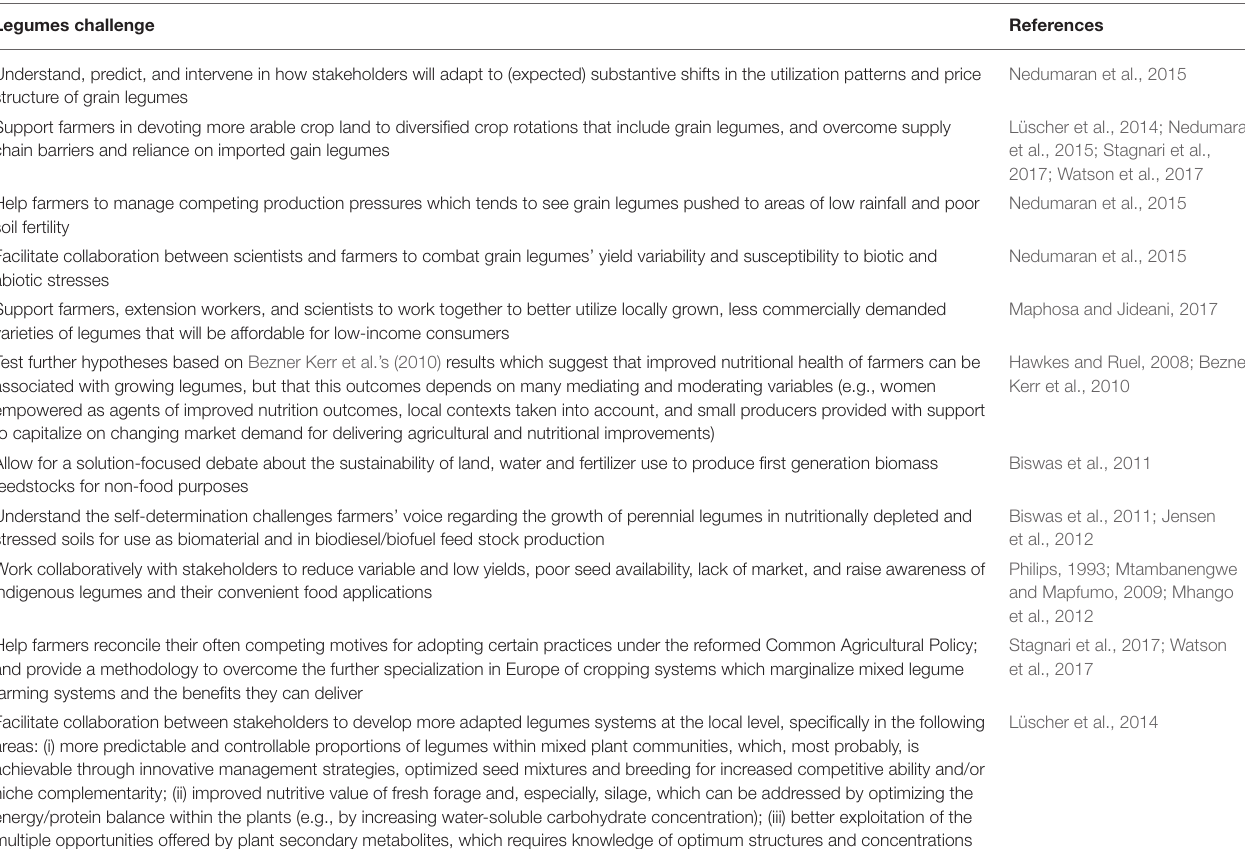
TABLE 1 | Examples of legumes research challenges that would benefit from the suggested approach. Legumes